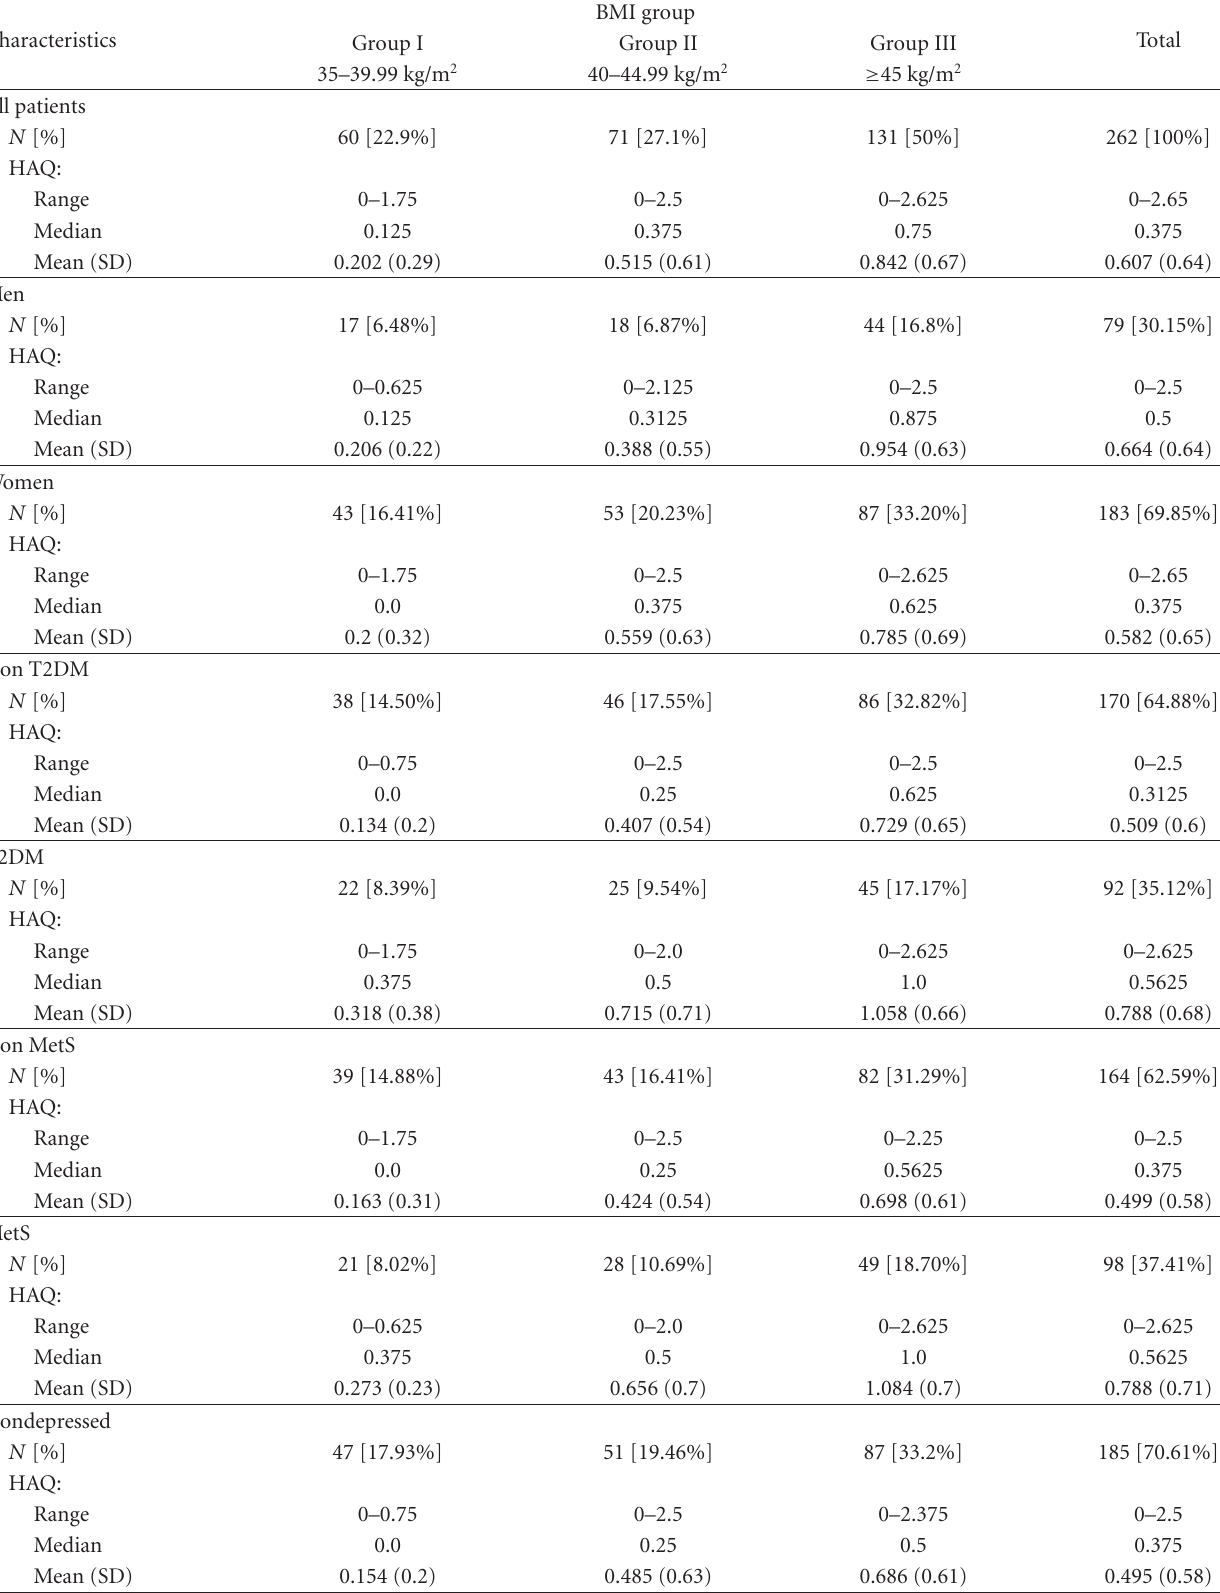
Table 2: Health Assessment Questionnaire (HAQ) disability index scores by body mass index (BMI) group, gender, and